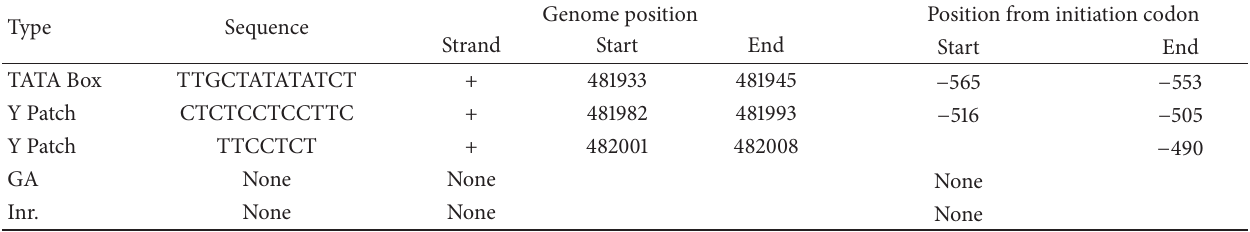
Table 3: Analysis of the 5 󸀠 -UTR region At3G02360 gene coding for Arabidopsis thaliana peroxisomal 6PGDH. Inr.: initiator. TATA box: an octamer group related to TATA box. Y patch: an octamer group of the pyrimidine (Y) patch. REG: regulatory element group, an octamer group related to cis -regulatory elements. CDS: protein coding region. UTR: untranslated